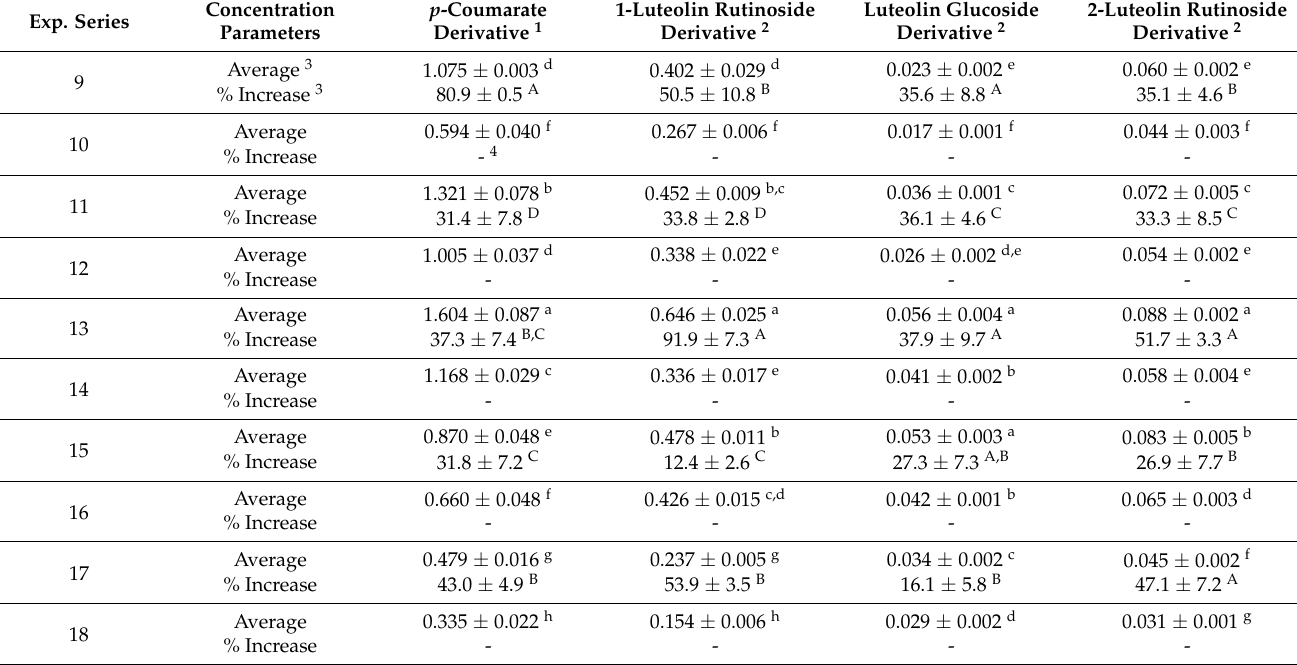
Table 4. Specific polyphenolic component groups’ concentrations (mg g − 1 dw) of the E. pungens extracts, obtained by applying five different hydroethanolic solvents during PEF